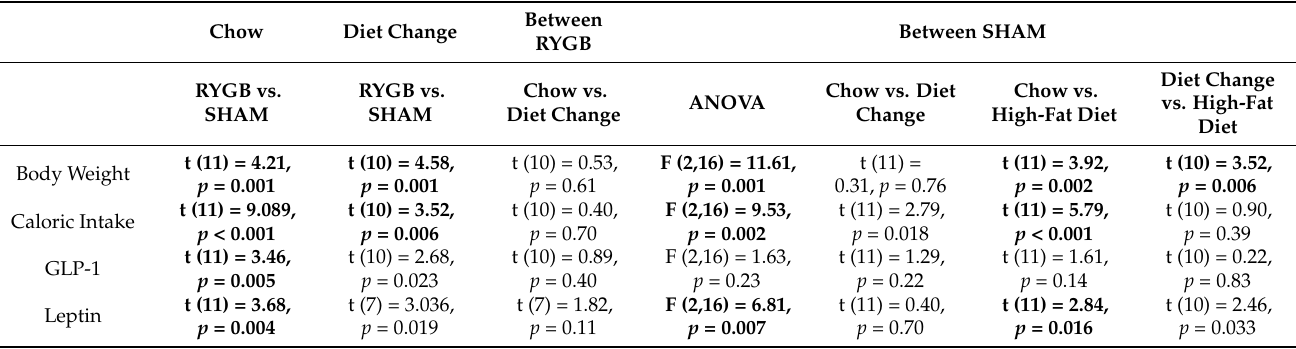
Table 8. Statistical analysis comparing outcomes of the hormone response tests. For paired com- parisons, uncorrected p -values are depicted; those that survived Bonferroni corrections are bolded . Significant ANOVAs are also bolded